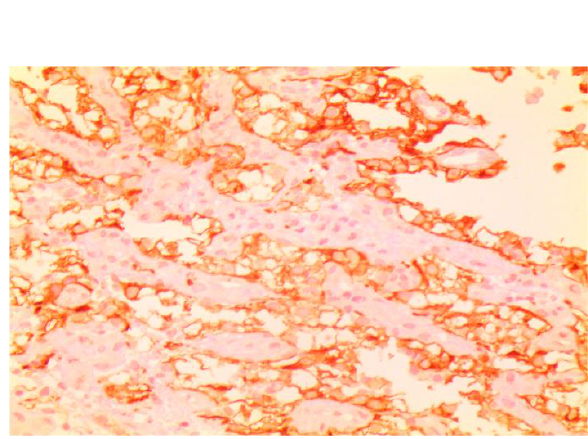
Fig 3. IHC; pan ck, vimentin and CD10 had positive results but CK7,CD68 were negative